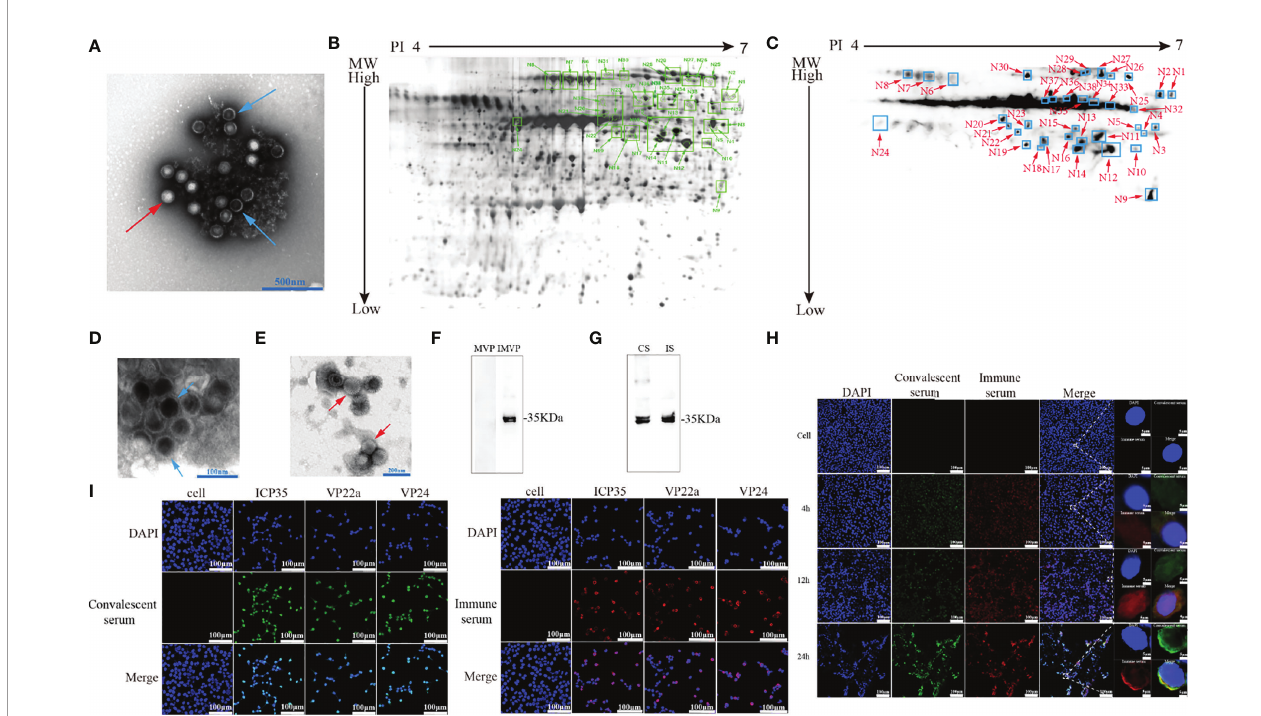
FIGURE 1 | Viral-encoded proteins were recognized by the convalescent serum from HSV2-infected patients. (A) Electron microscopy of puri fi ed HSV2 virus; the blue arrow indicates immatured virus particles and the red arrow indicates matured virus particles. (B) 2-D electrophoresis of puri fi ed HSV2 virus. The glue was stained by silver dyeing. The number marked in the fi gure represents the protein neutralized by HSV2 patient convalescent serum according with (C) . The speci fi c details are shown in the Table 2 . MW refers to Molecular weight; PI refers to Isoelectric point. (C) Immunoblotting showed that the convalescent serum could identify viral proteins in the puri fi ed HSV2 virus. (D) Electron microscopy of puri fi ed HSV2 virus; the blue arrow indicates immatured virus particles. (E) Electron microscopy of puri fi ed HSV2 virus; the red arrow indicates matured virus particles. (F) The immune-blotting of matured and immatured virus particles with convalescent serum. The results showed that only trace levels of ICP35 were detected in matured particles compared to uncompleted particles. MVP refers to matured virus particles. IMVP refers to immatured virus particles. The convalescent serum was used as the primary antibody, and the secondary antibody was horseradish peroxidase labeled goat anti-human IgG (H+L) antibody. (G) The immune-blotting of the prokaryotic expressed ICP35 with convalescent serum and immune serum of ICP35. The convalescent serum and immune serum were used as the primary antibody, and the secondary antibody was horseradish peroxidase labeled goat anti-human IgG (H+L) antibody and goat anti-rabbit IgG (H+L) antibody. CS refers to convalescent serum. IS refers to immune serum of ICP35. (H) The results of the immuno fl uorescence detection with convalescent serum and immune serum of expressed ICP35 after HSV-2 virus infection. Vero cells were infected with HSV-2 at a MOI of 0.2, and at 4h, 12h, 24h postinfection, the samples were harvested. Blue represents nuclear staining (DAPI); green (Alexa Fluor ® 488 Goat anti-human IgG) represents staining with the convalescent serum; red (Alexa Fluor ® 647 Goat pAb to Rb IgG) represents staining with the immune serum. (I) The results of the immuno fl uorescence detection with convalescent serum and immune serum of ICP35 after transfecting eukaryotic vectors containing ICP35, VP22a and VP24 into 293 cells respectively. Blue represents nuclear staining (DAPI); red (Alexa Fluor ® 647 Goat pAb to Rb IgG) represents staining with the immune serum; green (Alexa Fluor ® 488 Goat anti-human IgG) represents staining with the convalescent